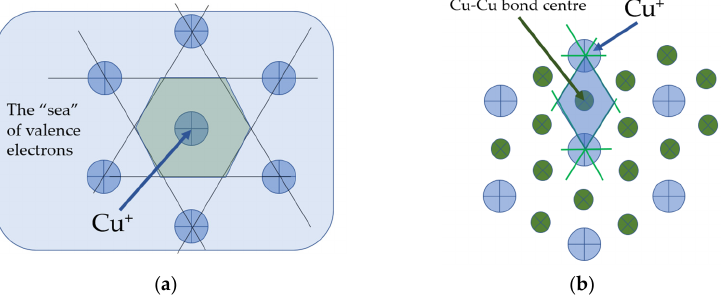
Figure 1. ( a ) The atomic lattice; ( b ) the corresponding congruent bond lattice (CBL) of Cu. Shadowed areas correspond to Cu-centred ( a ) and bond-centred ( b ) Voronoi polyhedrons.